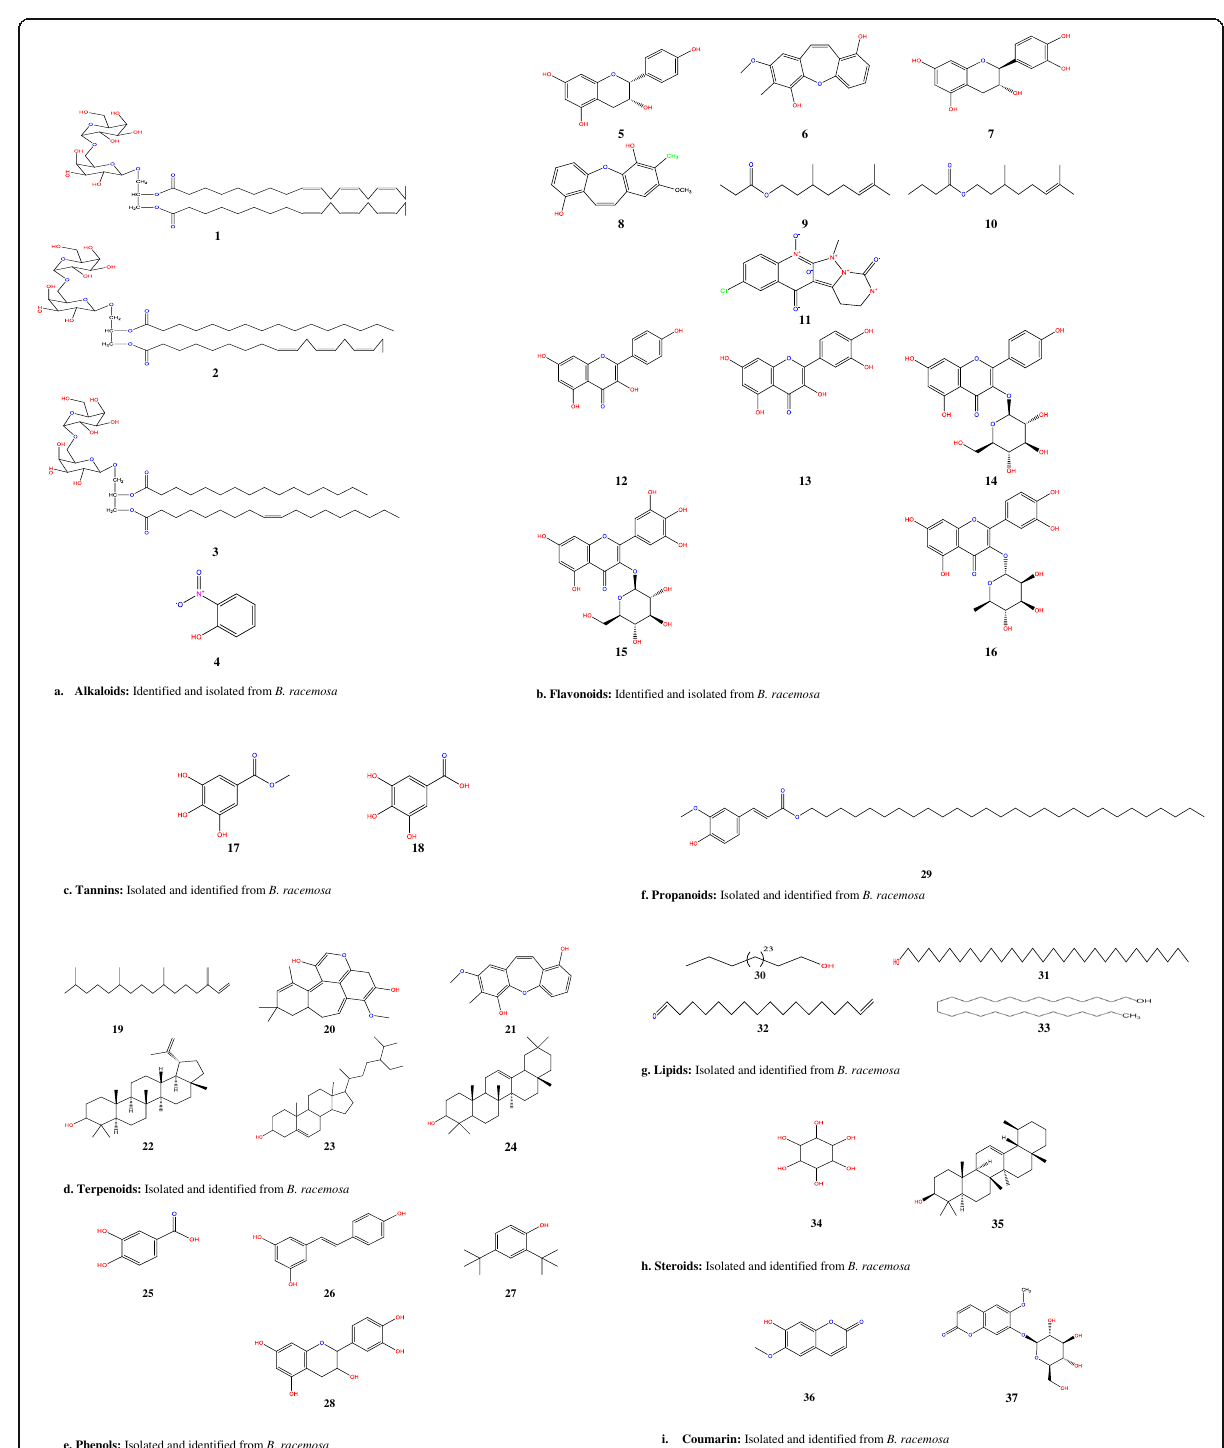
Fig. 1 Phyto-constituents of Bauhinia racemosa ( a – i ). a Alkaloids: identified and isolated from B . racemosa. b Flavonoids: identified and isolated from B . racemosa. c Tannins: isolated and identified from B. racemosa. d Terpenoids: isolated and identified from B. racemosa. e Phenols: isolated and identified from B . racemosa . f Propanoids: isolated and identified from B . racemosa . g Lipids: isolated and identified from B . racemosa . h Steroids: isolated and identified from B . racemosa . i Coumarin: isolated and identified from B .